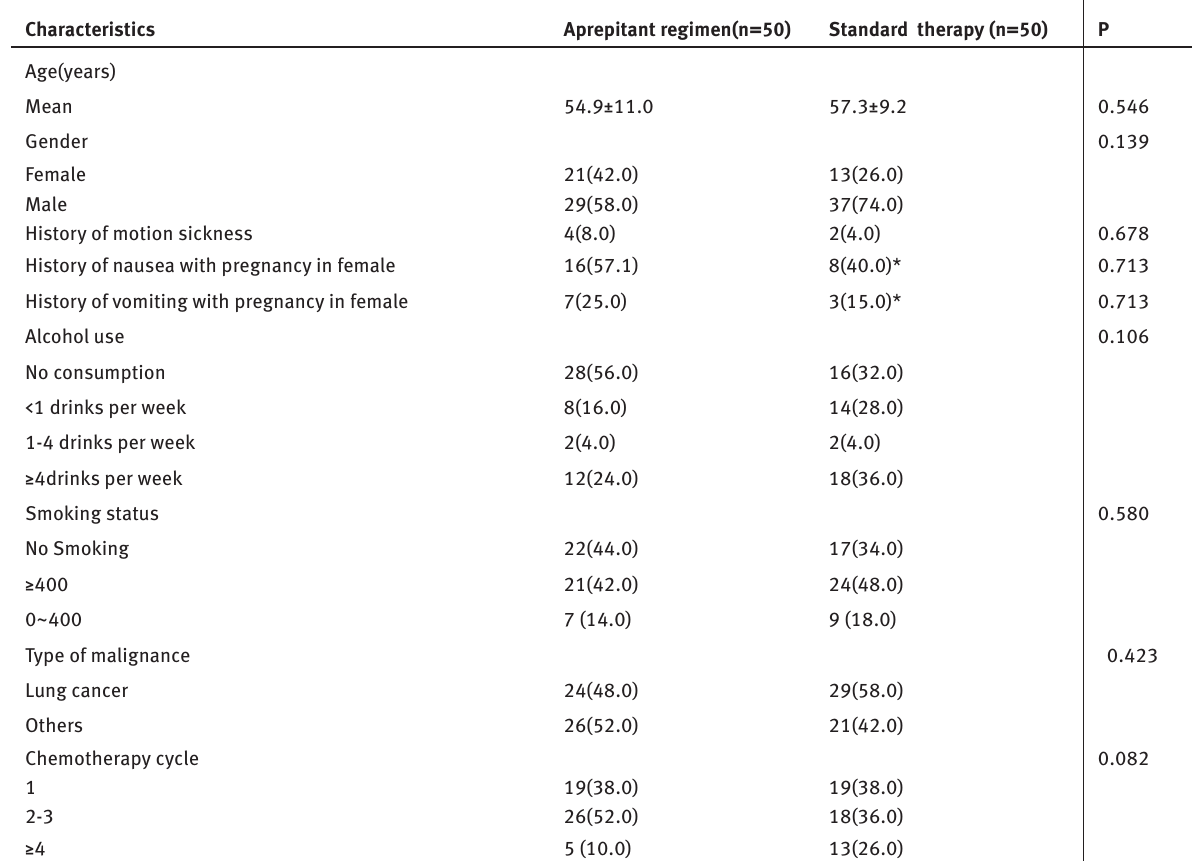
Table 1: Patients’ baseline characteristics [n(%)]